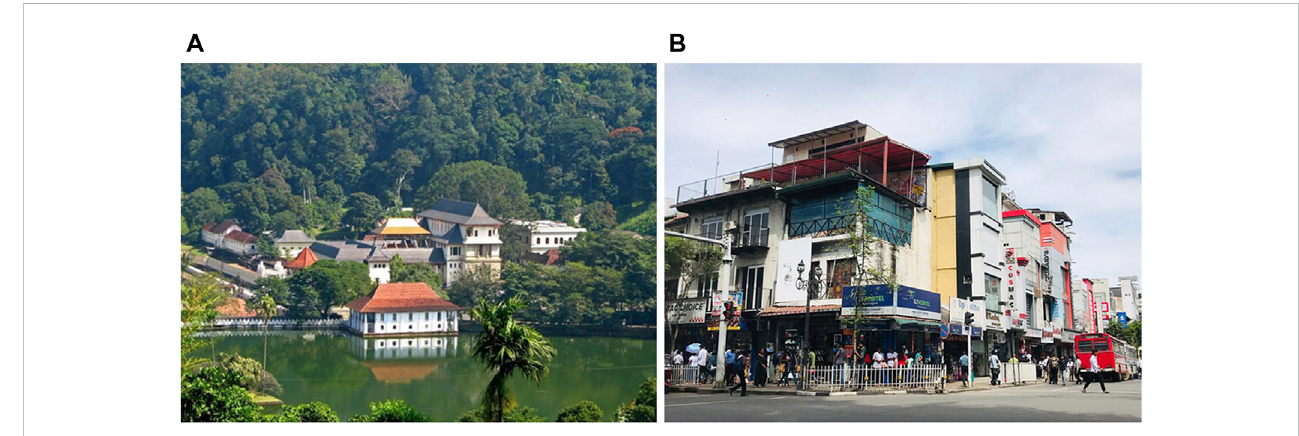
FIGURE 15 Kandy: (A) The Temple of the Tooth Relic of Buddha with the lake in the foreground and Udawatte Kele forest in the background; (B) the adhoc commercial constructions in the city